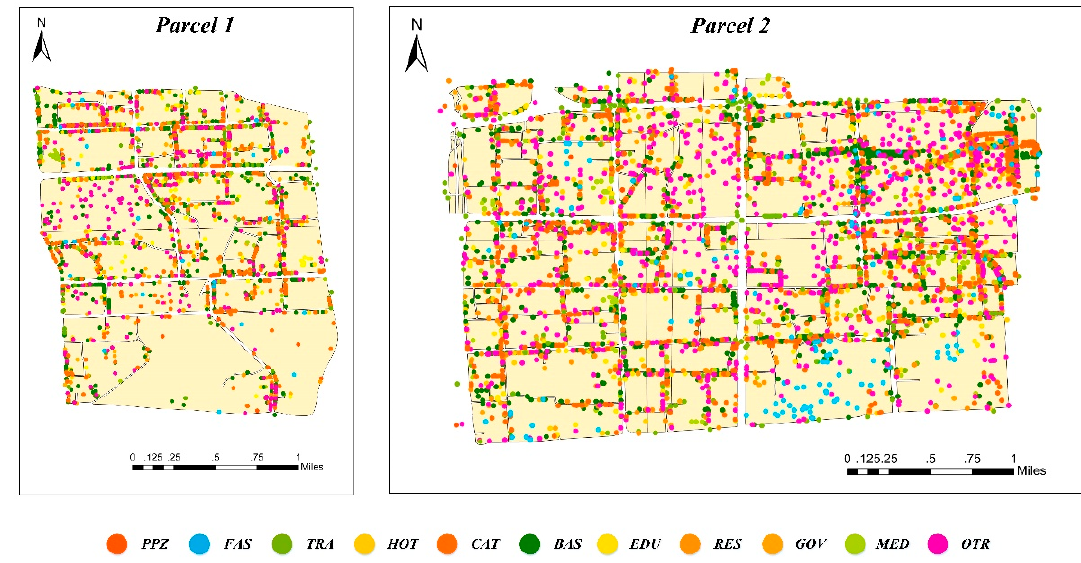
Figure 2. Illustration of two test parcel datasets.